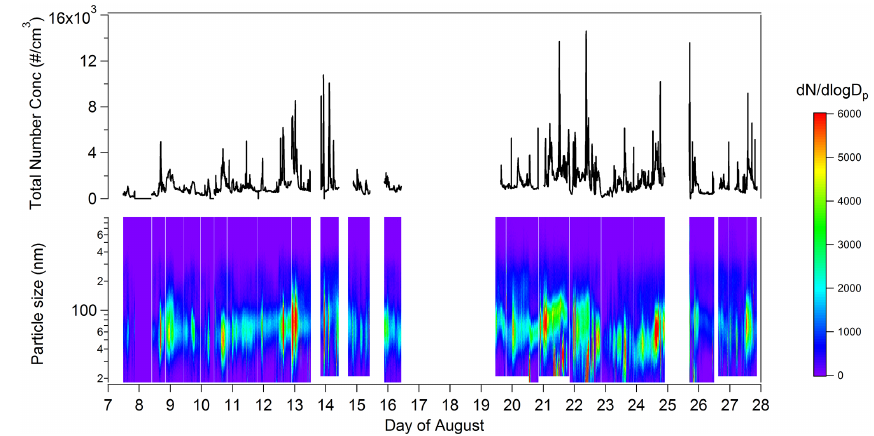
Figure 2. Time series (PDT) for 7–28 August of SMPS total number concentrations (top) particle size distribution (bottom). The colour bar indicates d N /dlog D p in the bottom